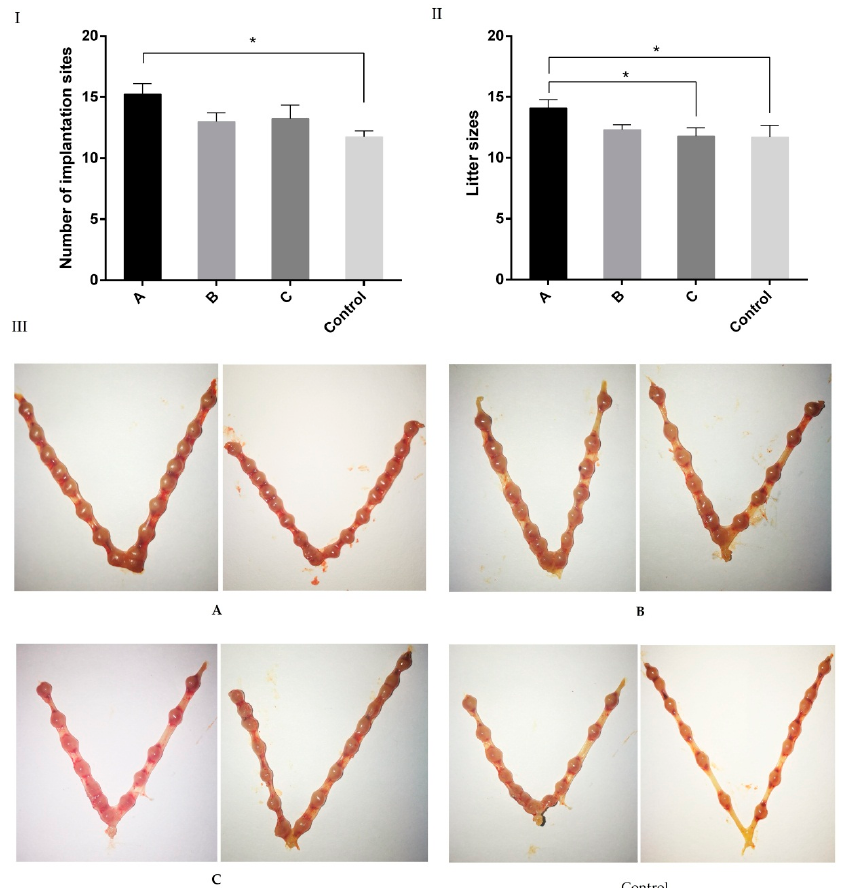
Figure 3. Effect of melatonin on the implantation sites and litter sizes. Mice were treated with melatonin (4.3 µ g/mL) in drinking water. ( A ) Melatonin was given 14 days before mating (vaginal plugs was detected); ( B ) melatonin was given from the mating to the delivery; ( C ) melatonin was given from 14 days before mating to the delivery. ( Control ) without any treatment. n = 10. ( I ) Number of implantation sites; ( II ) Litter size; ( III ) Representative images of implantation sites in each group. “*” represents a significant difference between the different groups ( p < 0.05).